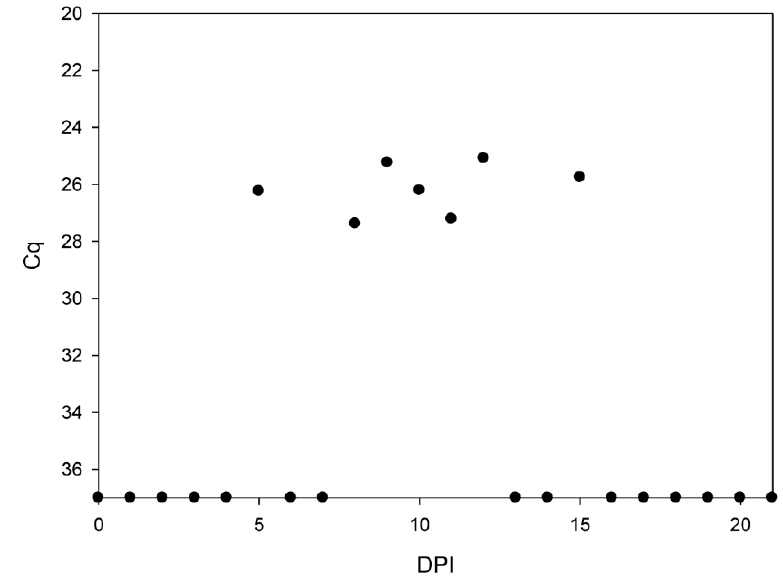
Figure 3. Quantification of IAV RNA loads by RT-qPCR in pooled fecal samples. The amounts of viral genome load were measured by RT-qPCR at the indicated time points. Prior to extraction the guano samples were diluted 1:1000. Calculated values are presented.